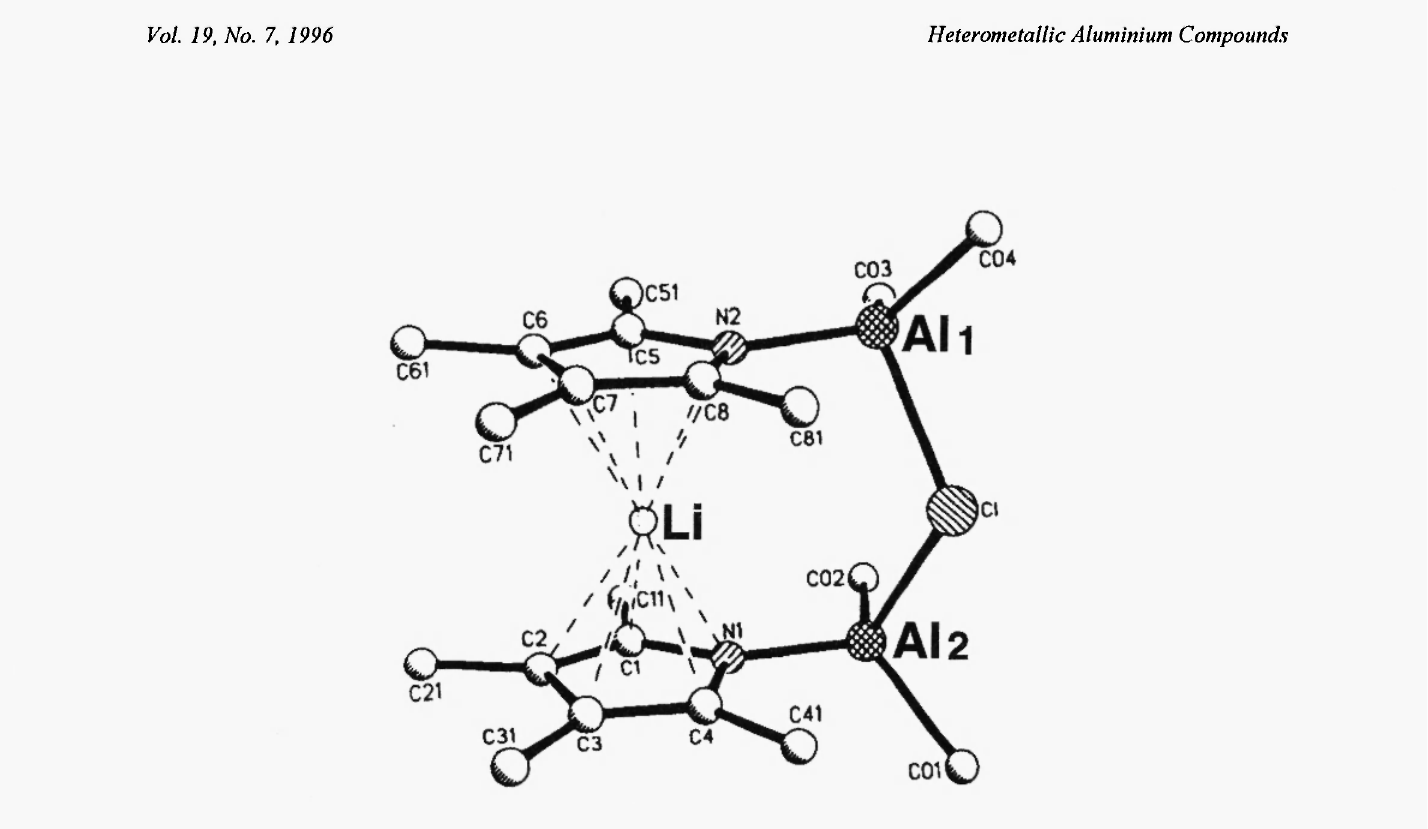
N}(Me )AI^-CI)AI(Me) 4 2